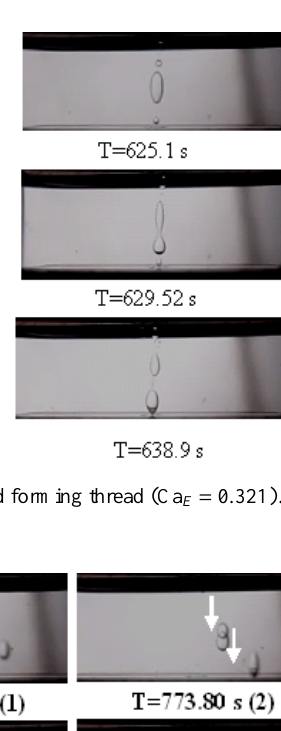
Fig. 12. The second type of droplet coalescence (Ca